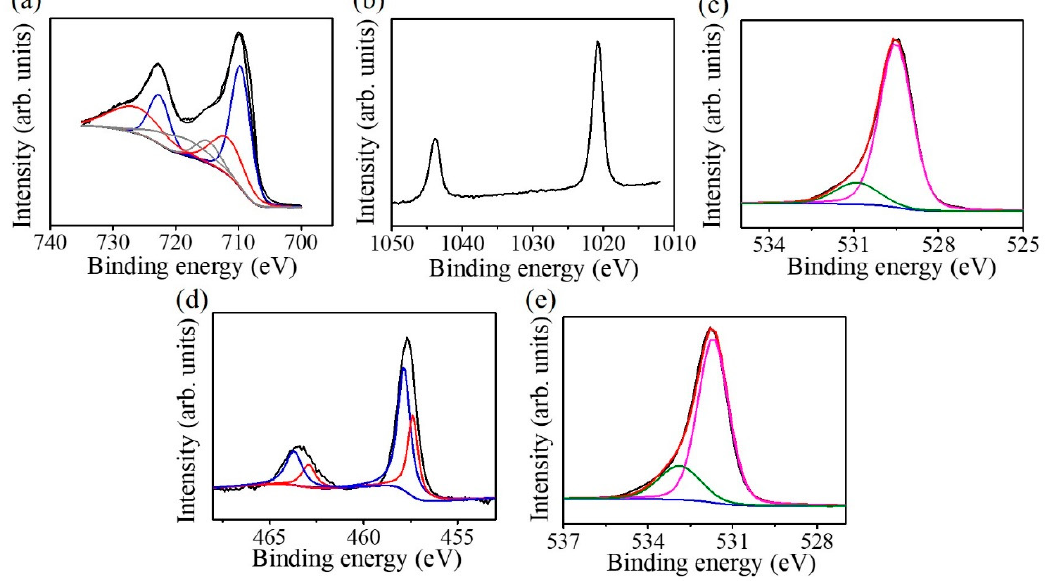
Figure 7. XPS spectra of the ZFO thin film: ( a ) Fe2p; ( b ) Zn2p; ( c ) O1s. XPS spectra of the TiO 2 nanorods: ( d ) Ti2p; ( e ) O1s.